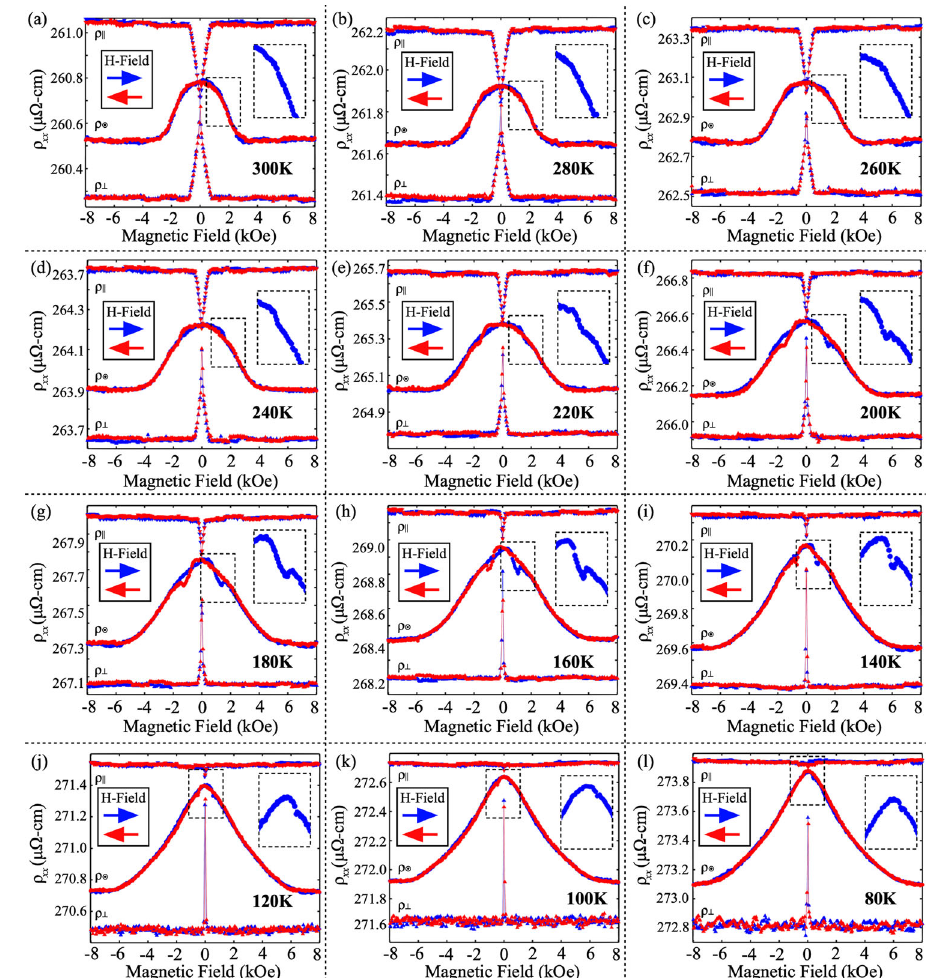
), transverse ( ρ ? ), and polar xx xx